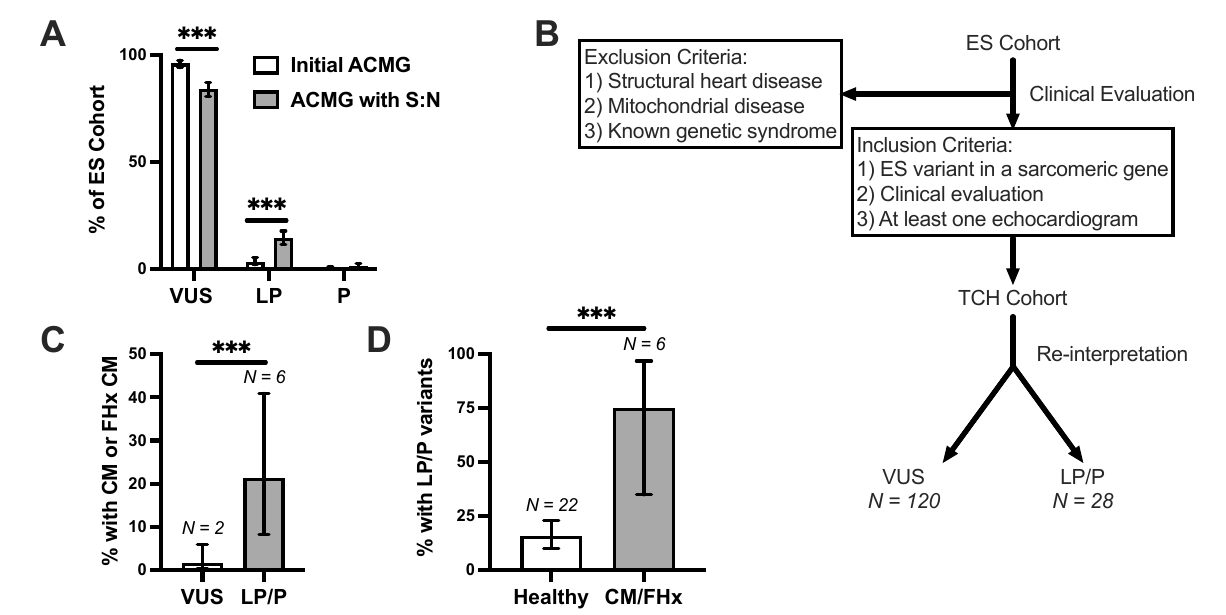
Figure 5. ( A ), Bar graph demonstrating proportion of pathogenic (P), likely pathogenic (LP), and variants of uncertain significance (VUS) using American College of Medical Genetics and Genomics (ACMG) criteria before and after re-assignment with signal-to-noise (S:N). ( B ), Exome sequencing (ES) cohort was assigned pathogenicity based on 2015 ACMG criteria. A retrospective clinical analysis was performed on those patients seen at Texas Children’s Hospital (TCH) following exclusion of subjects with structural heart disease, mitochondrial disease, or chromosomal abnormalities, or those without echocardiogram. ( C ), Bar graph showing the percentage of individuals with cardiomyopathy (CM) or first-degree family history (FHx) of cardiomyopathy out of TCH cohort probands hosting VUSs or LP/P variants. ( D ), Bar graph highlighting the percentage of individuals hosting LP/P variants out of TCH cohort probands with a negative clinical evaluation or cardiomyopathy or first-degree family history of cardiomyopathy. ***, p <